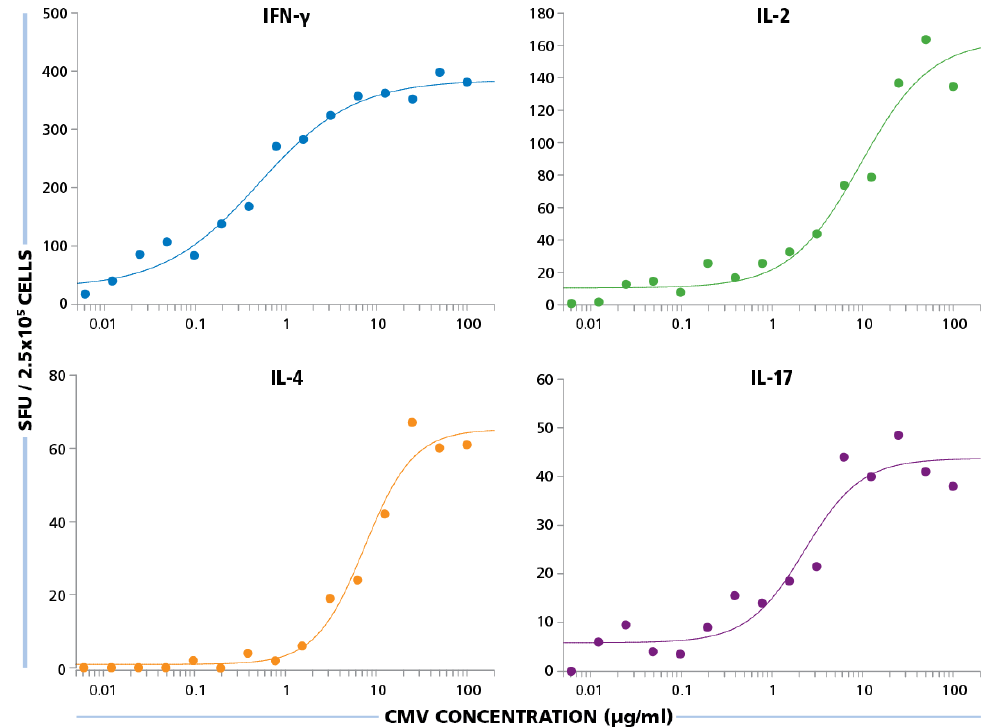
Figure 6. Establishing optimal antigen dose for HCMV-specific CD4 cell stimulation. PBMC were plated at 250,000 cells per well and was stimulated with different concentrations of HCMV antigen starting from 100 μg/mL to 0.01 μg/mL. SFU recorded from IFN-γ, IL-2,